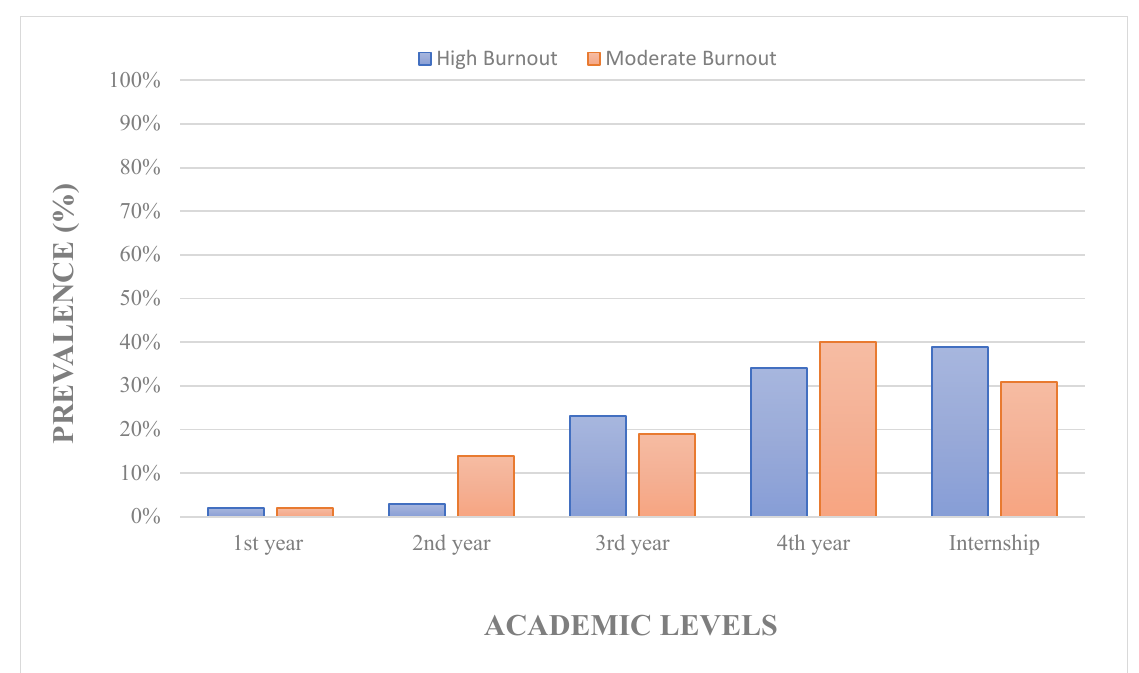
Figure 2. Prevalence of RT students and interns experiencing burnout across academic levels.